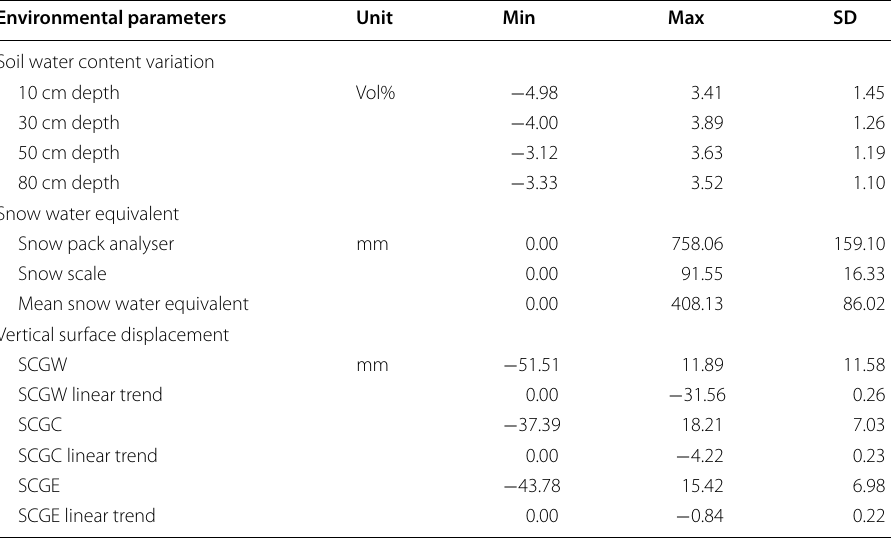
Table 2 Quantities of environmental parameters (except tides) determined for the three gravity stations at Þeistareykir; including minima, maxima and standard deviations for soil water content variations at different soil depths, snow water equivalent and vertical surface displacement Environmental parameters Unit Min Max